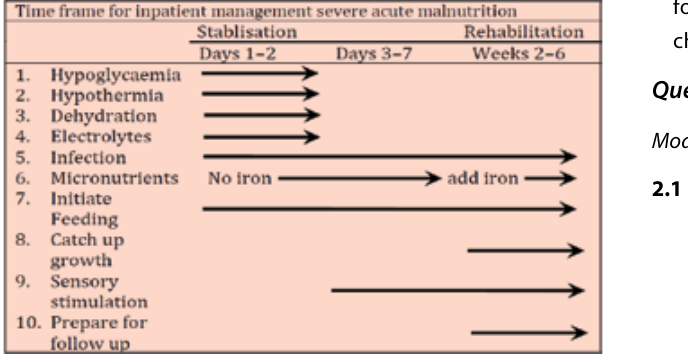
Figure 2: Time frame for the inpatient management of